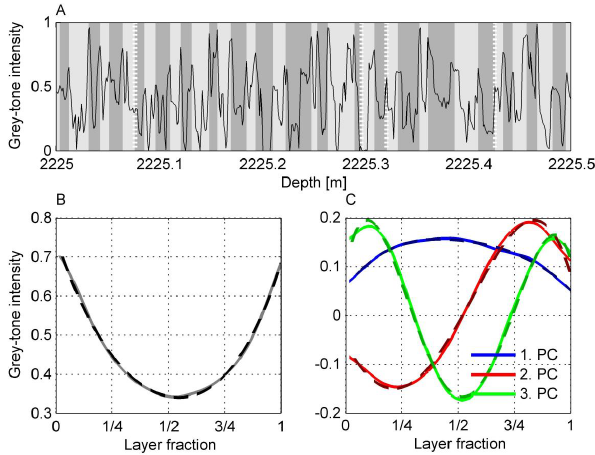
Fig. 2. (A) Section of line-scan data with manually counted annual Fig. 2: (A) Section of line-scan data with manually counted annual layers indicated by 2 layers indicated by alternating bright and dark grey bands. White alternating bright and dark grey bands. White dashed layer boundaries are regarded as 3 dashed layer boundaries are regarded as uncertain. Prior to analysis, uncertain. Prior to analysis, data were treated by taking the logarithm of the grey-tone 4 data were treated by taking the logarithm of the grey-tone intensity intensity values and normalizing according to minimum/maximum values. (B) Mean annual 5 values and normalising according to minimum/maximum values. layer trajectory and (C) the first three principal components of the deviation from the mean 6 (B) Mean annual layer trajectory and (C) the first three principal trajectory during the cold period (depth: 2225-2240 m). 4 th order polynomial fits to the mean 7 components of the deviation from the mean trajectory during the and principal components are shown as dashed lines. 8 cold period GS-13 (depth: 2225–2240m). 4th order polynomial fits to the mean and principal components are shown as dashed